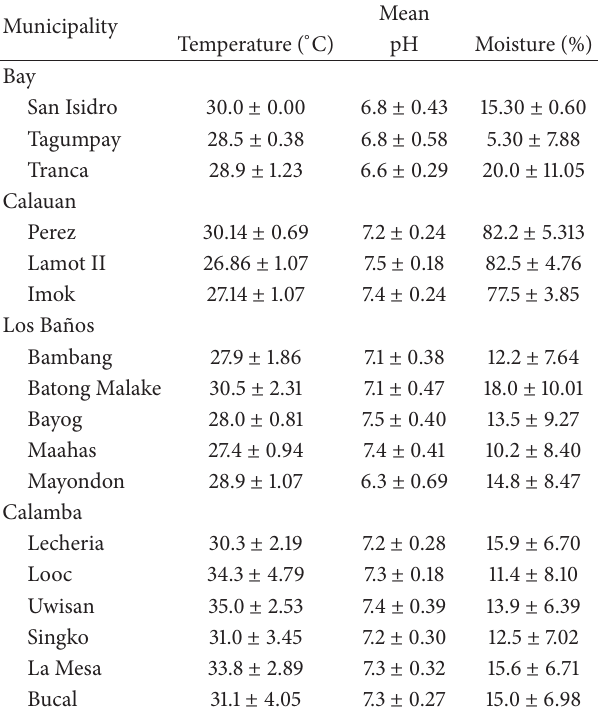
𝑃 = 0.373 ). The mean egg density for Calamba was 2 eggs/g